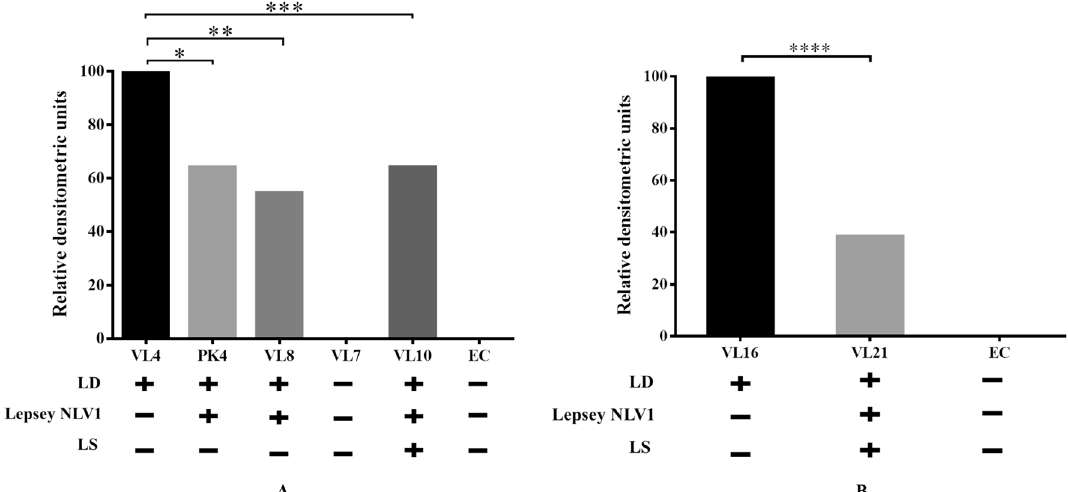
Figure 2. The levels of IL-18 in serum samples. Relative densitometric units as obtained in Proteome Profiler, were normalized in respect of only LD-containing samples. Samples were chosen based on LD, LS and Lepsey NLV1 test results. Sample VL7 was from a LD treated patient. “ + ” and “ − ” signs represent the presence and absence of three different microbes- Leishmaina donovani (LD), Leptomonas seymouri narna like virus 1 (Lepsey NLV1) and Leptomonas seymouri (LS). Panels A and B represent two different sets of experiments. EC-Endemic control. ‘ p ’ values were calculated from actual densitometric units observed from four replicates under each condition, by two tailed, unpaired t test at 95% level of significance. (* p = 0.0008, ** p = 0.0005, *** p = 0.0007, **** p = 0.0002).